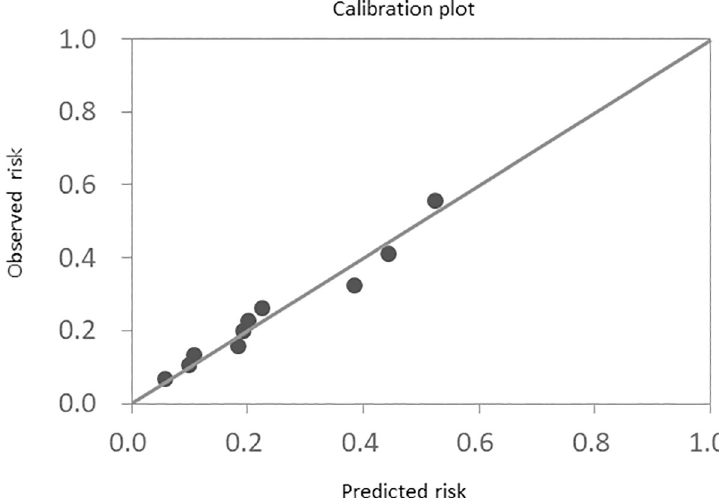
Fig 3. Calibration plot. Calibration plot of the 1-year hospitalization model for worsening of heart failure (external